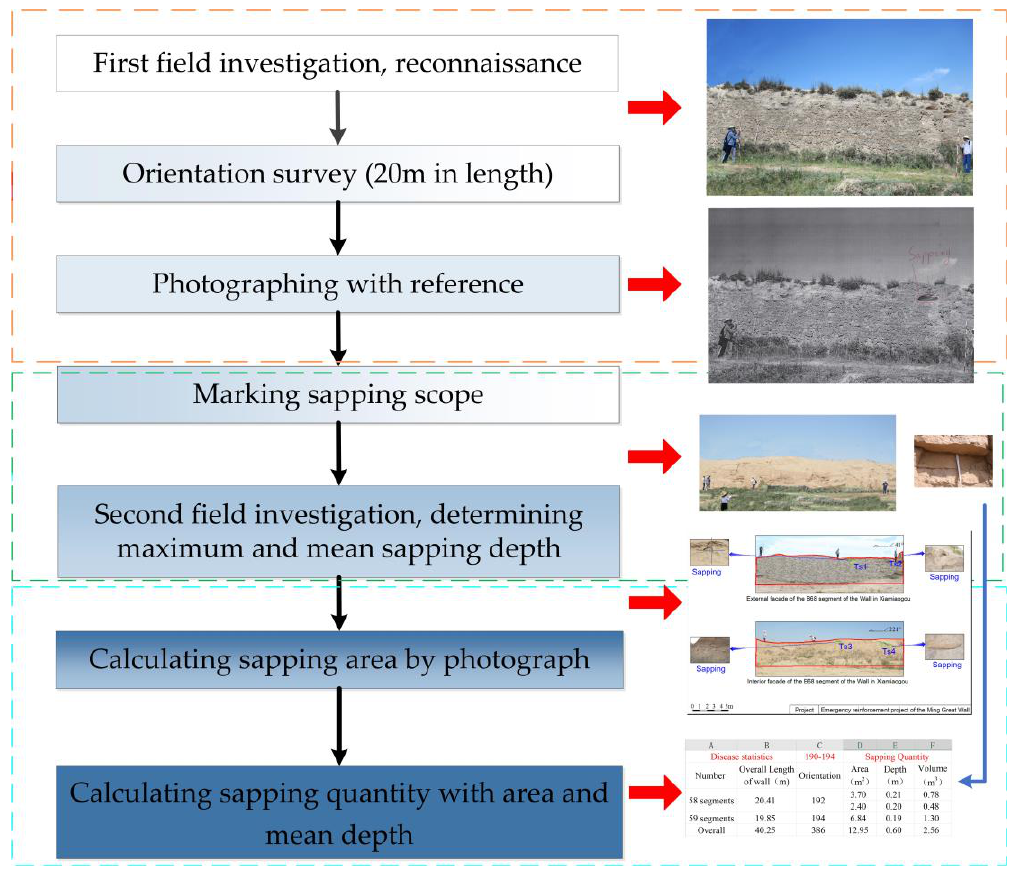
Figure 5. Calculation procedure of sapping quantity of the Great Wall.